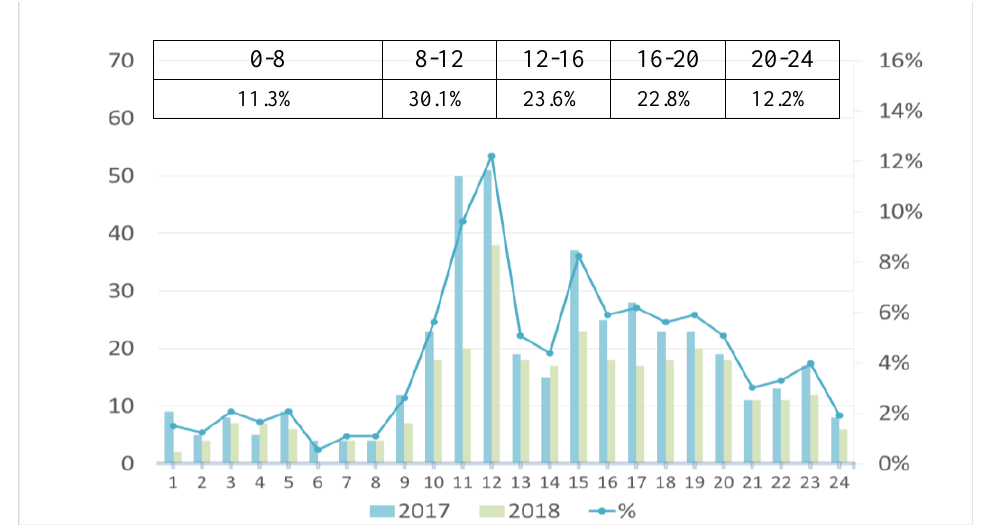
Figure 1. Distribution of telephone call time of 24-hour specialist palliative care telephone advice service.